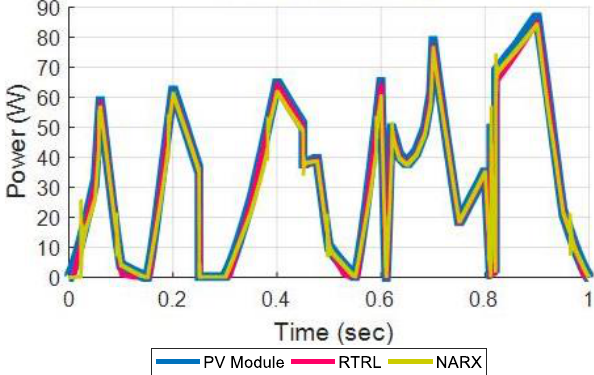
Figure 23. Results obtained with the RTRL and NARX controllers for variable signals of irradiance and temperature.